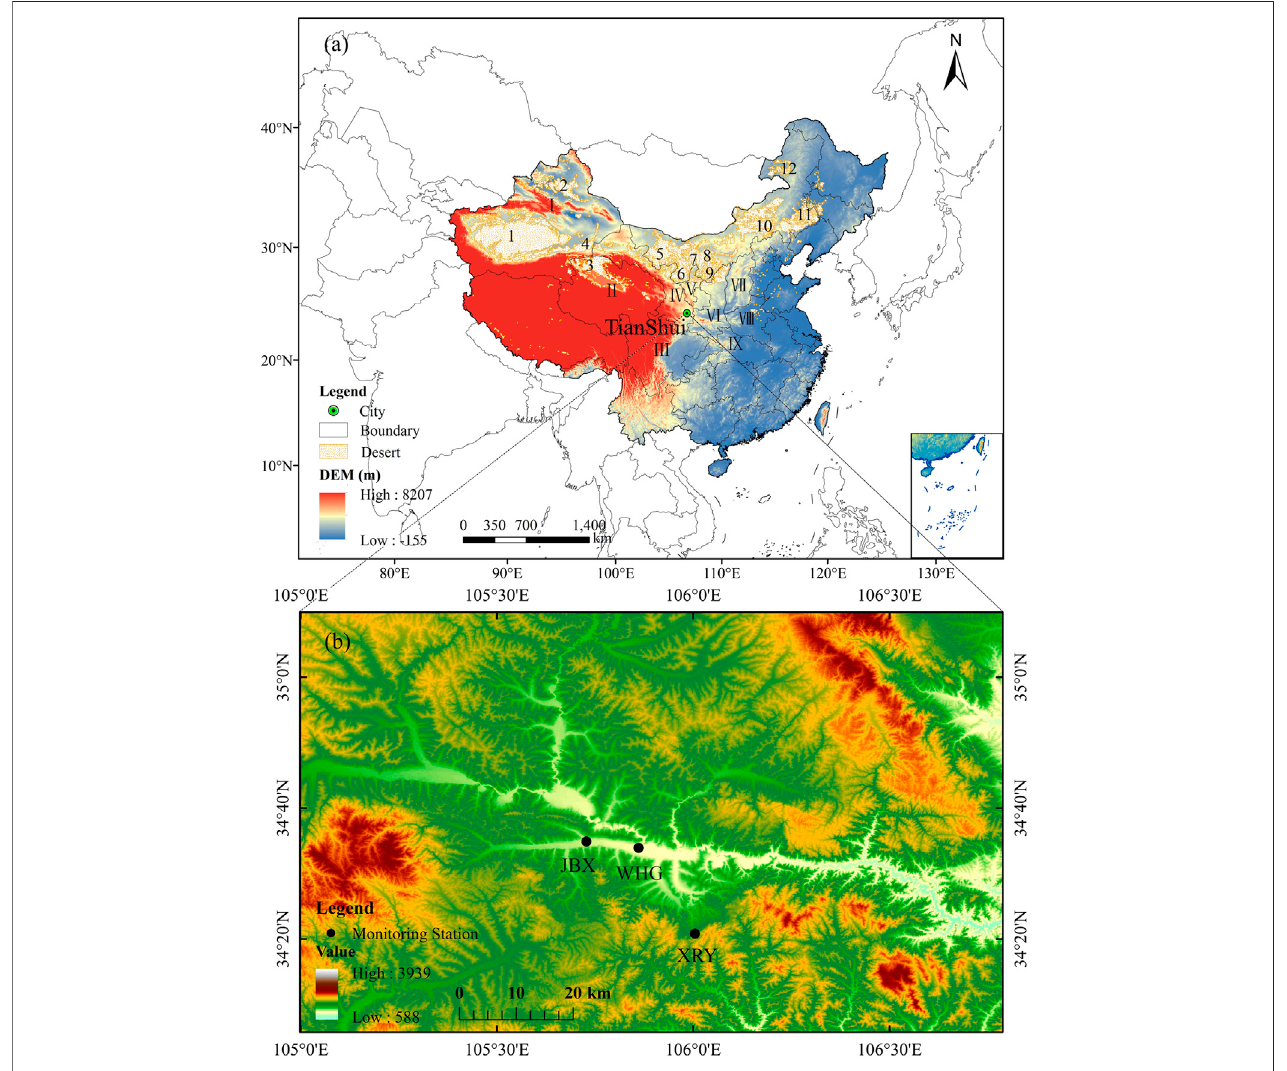
FIGURE1| Digitalelevation datafortheareasurroundingTianshui. Thedataweredownloadedfromthegeospatialdatacloud(HYPERLINK “ http://www.gscloud. cn/ ” \o “ http://www.gscloud.cn/ ” http://www.gscloud.cn/) and processed using ArcGIS 10.2 software. (A) Map of China and a location map of the receptor sites: